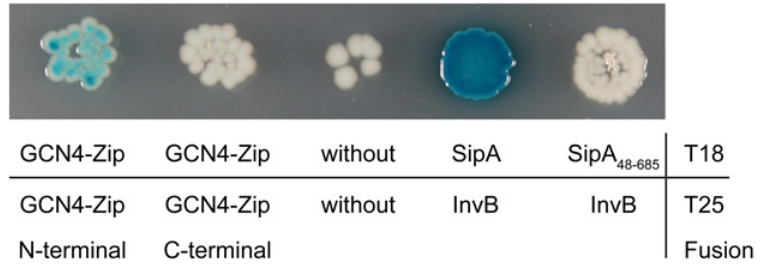
Fig 4. Gateway-based B2H assay for detection of chaperone-effector interaction. Expression clones encoding reporter gene fusions GCN4-Zip N-terminal (T25-GCN4-Zip/T18-GCN4-Zip), GCN4-Zip C-terminal (GCN4-Zip-T25/GCN4-Zip-T18), unfused T18 and T25 fragments (without), SipA-InvB (InvB-T25/SipA-T18) and SipA 48 – 685 -InvB (InvB-T25/SipA 48 – 685 -T18) were co-expressed in the cyaA -deficient E . coli B2H reporter strain BTH101. Blue colonies indicate protein-protein interaction through T18/T25 CyaA fragment complementation.